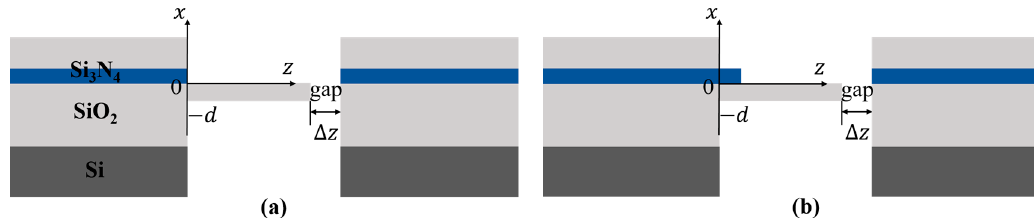
Schematic of the optical waveguide sensors: ( a ) conventional structure and ( b ) improved structure.